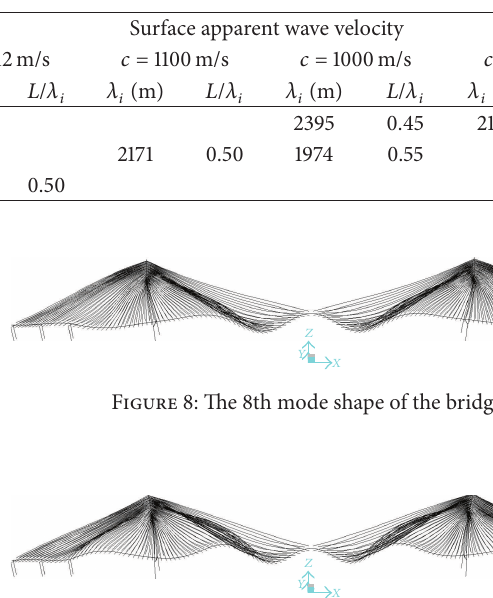
Figure 9: The 12th mode shape of the